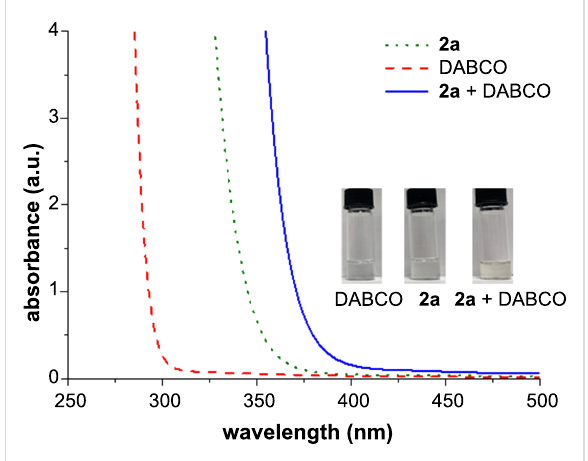
Figure 2: Optical absorption spectra recorded in acetonitrile in 1 cm path quartz cuvettes. [DABCO]: 0.5 M; [ 2a ]: 0.5 M.